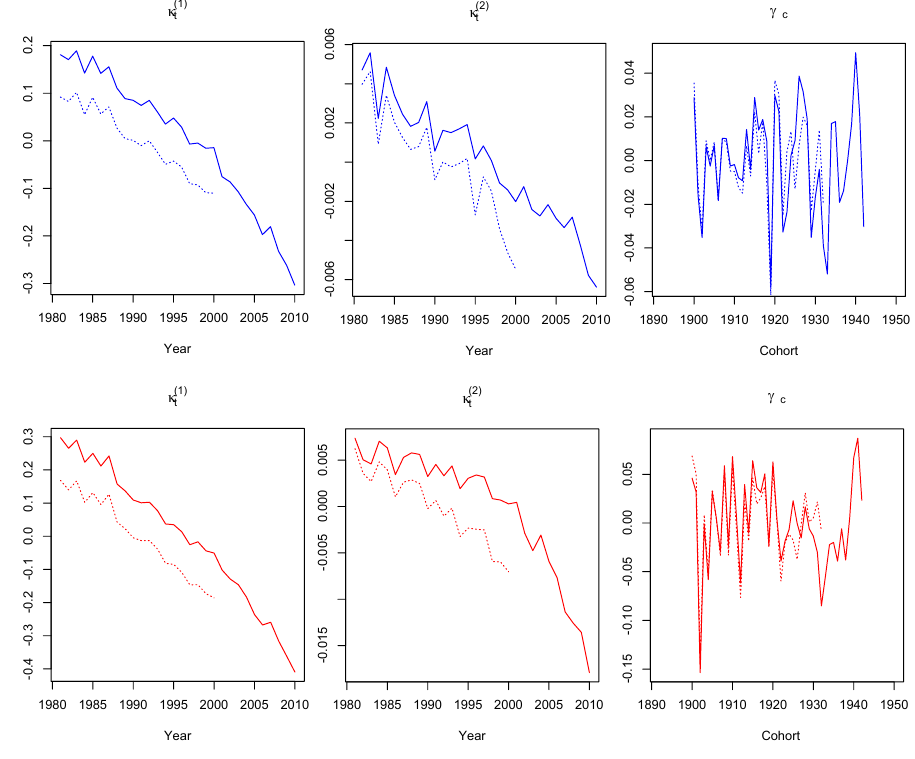
( 1 ) ( 1 ) Figure 4. M 4 : β and γ c estimated parameters for males ( top panels) and females ( bottom x , κ t panels), aged 60–89, fitted in 1981–2010 (solid lines) and 1981–2000 (dotted